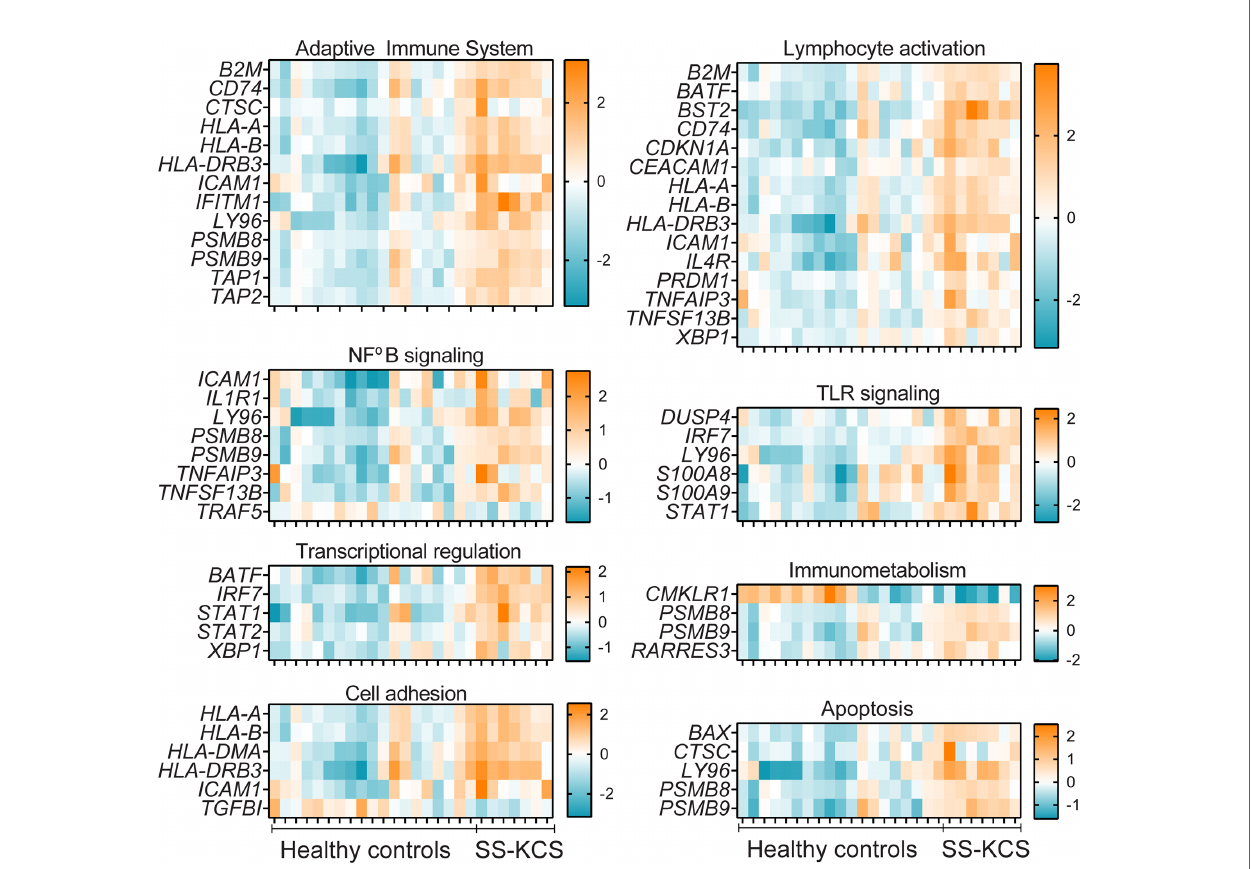
FIGURE 4 | Heatmaps of Adaptive immune system, Lymphocyte activation, NFkB, TLR signaling, Transcriptional regulation, Immunometabolism, Cell adhesion, and apoptosis. The downregulated genes TRAF5, CMKLR1 , and TGFBI , are found in the NFkB signaling, Immunometabolism, and Cell adhesion